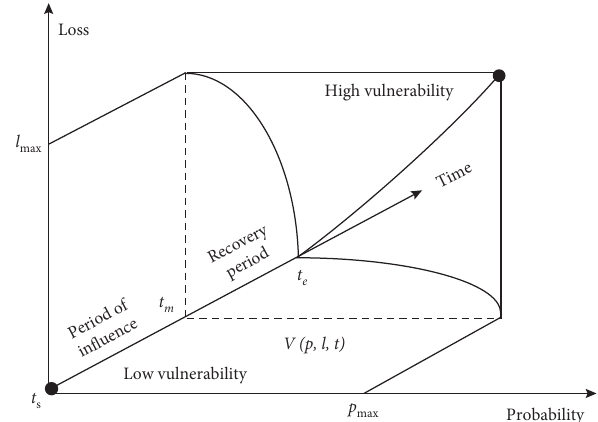
Figure 1: Three-dimensional model of road network vulnerability concept.